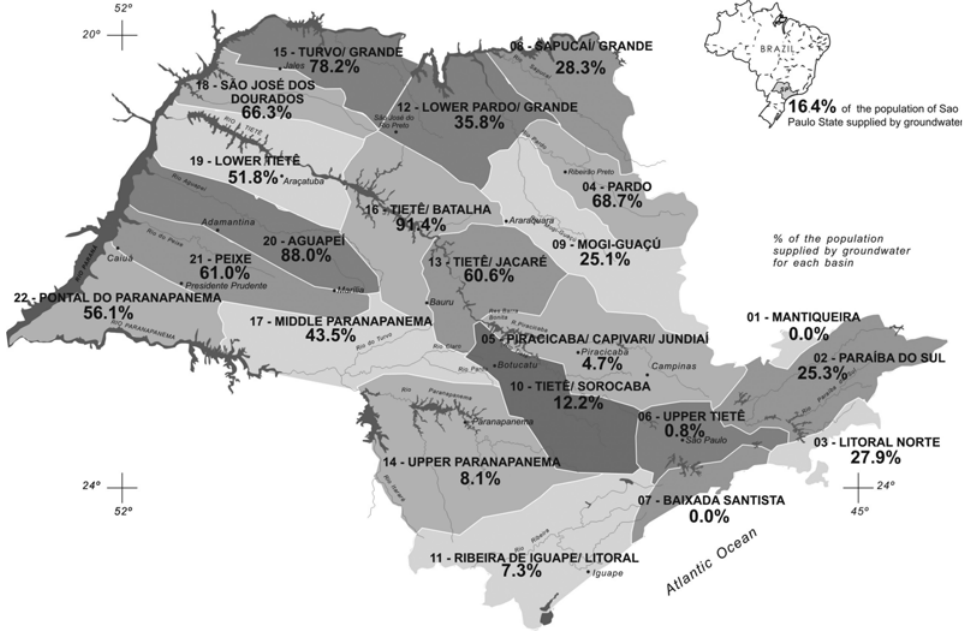
Fig. 2 – Percentage of the population supplied by groundwater for each Water Resource Management Units (WRMU) (associated to the main watershed) in the state of São